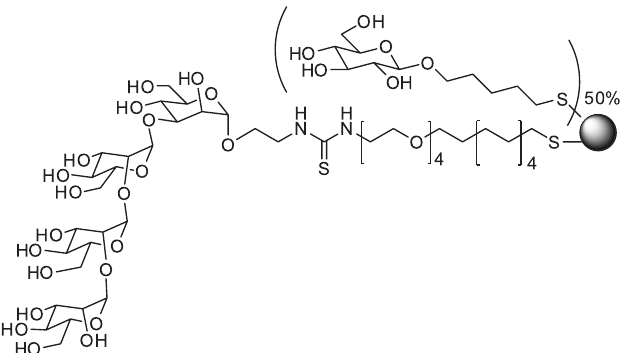
FIGURE 2 - Gold glyconanoparticle with 50% of glucose and 50% of a linear tetrasaccharide.